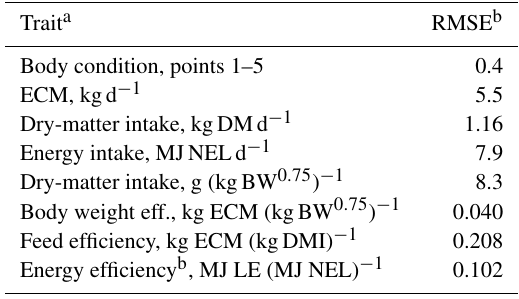
Table 3. Root mean square error of efficiency and production traits. Trait